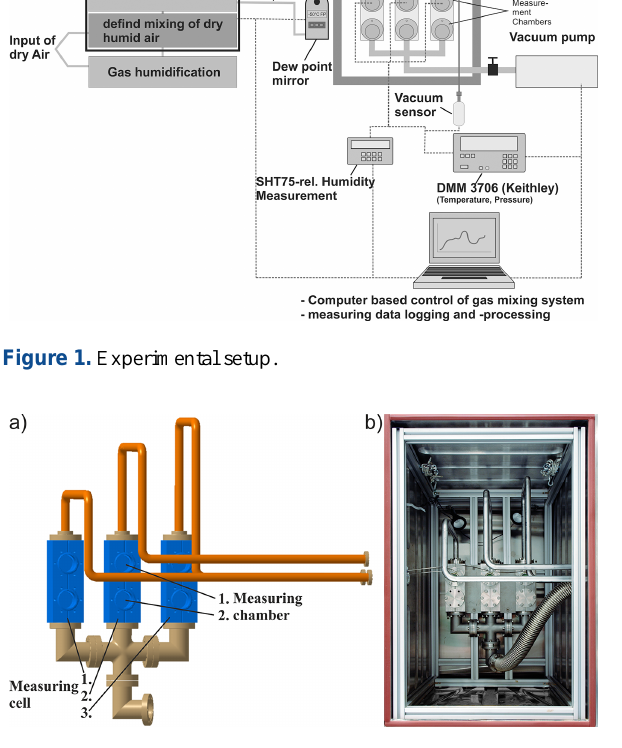
Figure 2. (a) Illustration of measuring cells and pipe routing inside the temperature test chamber; (b) temperature test chamber with measuring